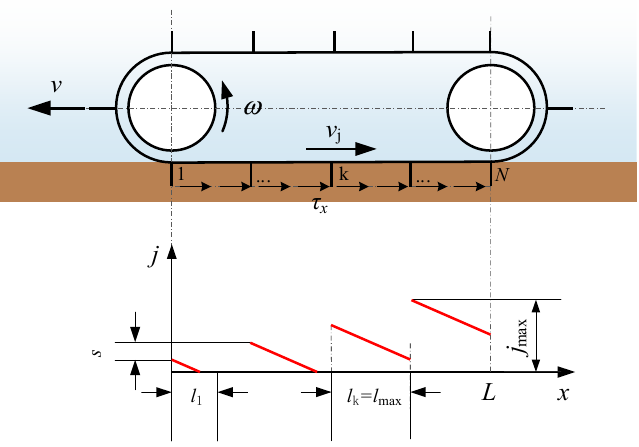
Figure 16. Actual shear displacement of DPNC.